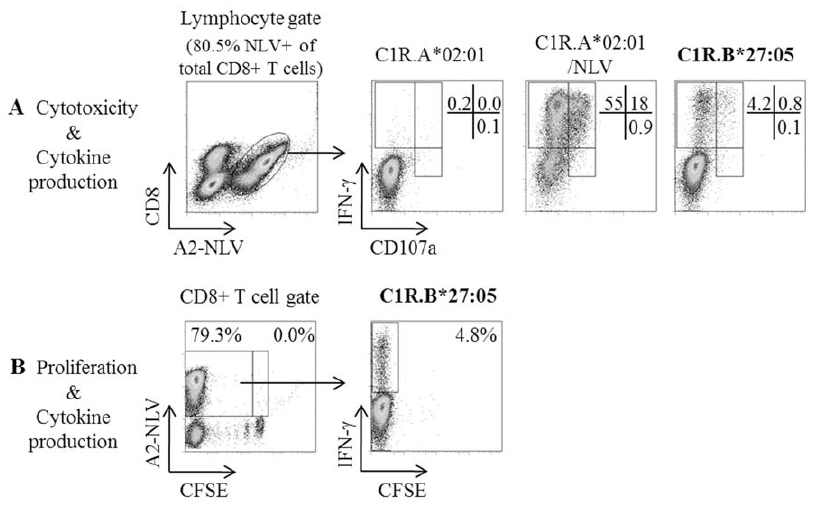
Figure 2. Functional analyses of new cross-reactivity towards B*27:05. Flow cytometric analyses of IFN- c and CD107a expression were performed after 13 days of NLV-specific T cell expansion from HC5. T cell cultures were stimulated with C1R.A*02:01 (negative control), NLV-pulsed C1R.A*02:01 (positive control) or C1R.B*27:05 (cross-reactive target) for 6 hours in a combined CD107a staining and ICS assay revealing that cross- reactivity was mainly via cytokine production (IFN- c + ) and to a lesser extent dual cytokine/cytotoxic ability (IFN- c + /CD107a + ) (A). Both proliferation and cytokine production were measured in a parallel experiment after CFSE-labelled PBMCs from HC5 were cultured with autologous irradiated NLV- pulsed PBMCs for 13 days before performing a 6 hour ICS assay (B). The lymphocyte gate was based on side scatter versus forward scatter. CD8 + T